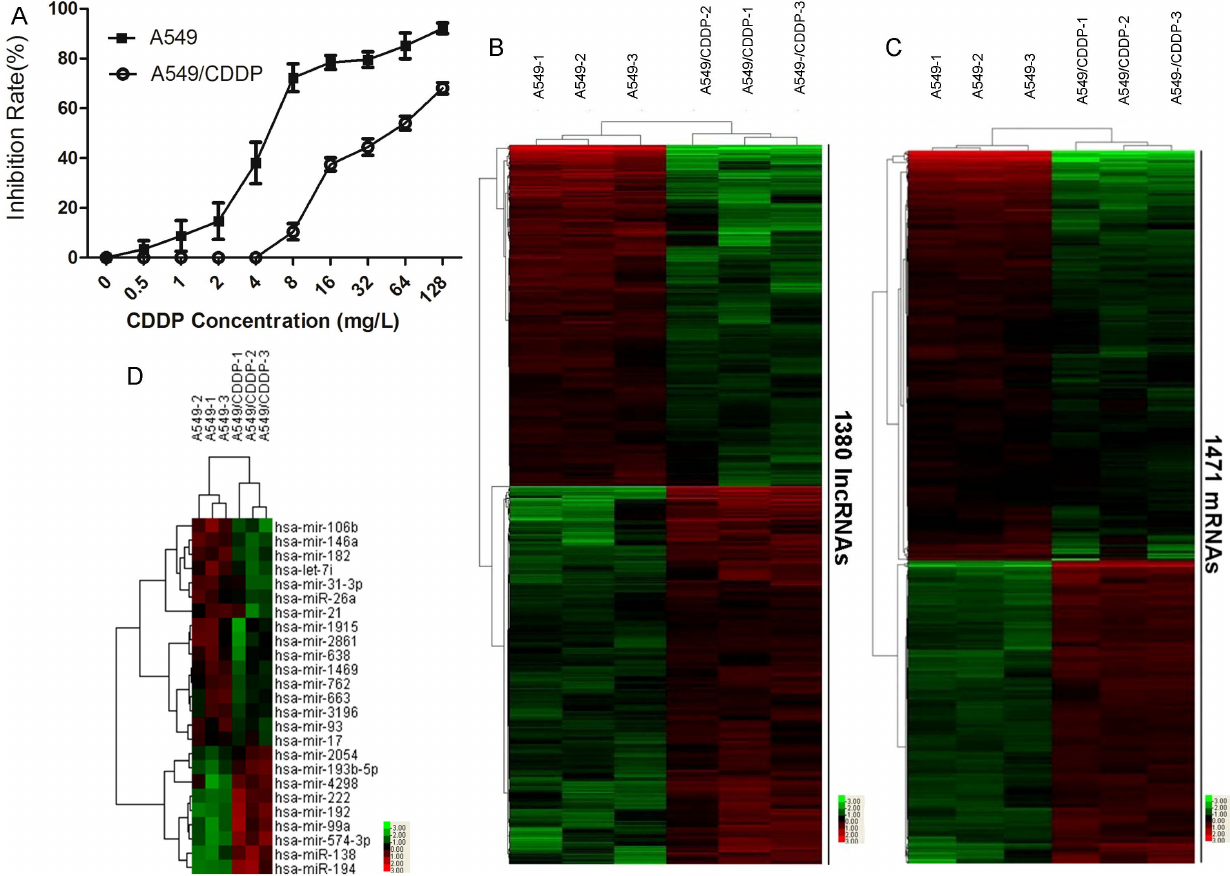
Figure 1. The RNA expression profiles and ciapatin resistance of A549 and A549/CDDP cells. Cells were treated with increasing concentrations of cisplatin (0.5 mg/L to 128 mg/L). 48 hours later, cell viability was measured by MTS (A). Heat maps show lncRNA (B), mRNA (C) and miRNAs (D) profiles that differentiate A549/CDDP from A549. Each sample was assayed in triplicate. Both down-regulated (green) and up-regulated (red) RNAs were identified in A549.